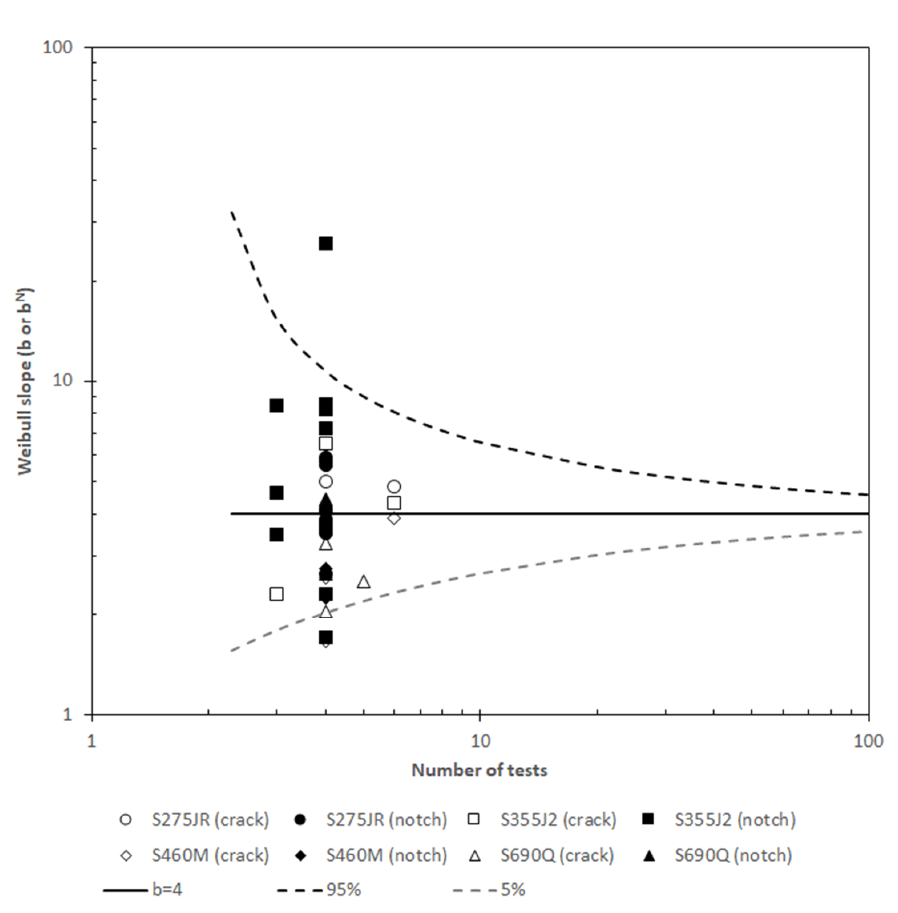
Figure 5. Comparison of relative 90% confidence limits for estimates of the Weibull slope (bias- corrected maximum likelihood estimation method [40]).